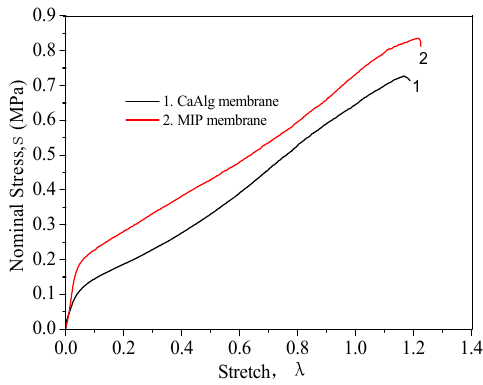
Figure 5. Stress–strain curves of CaAlg membrane and MIP membrane.